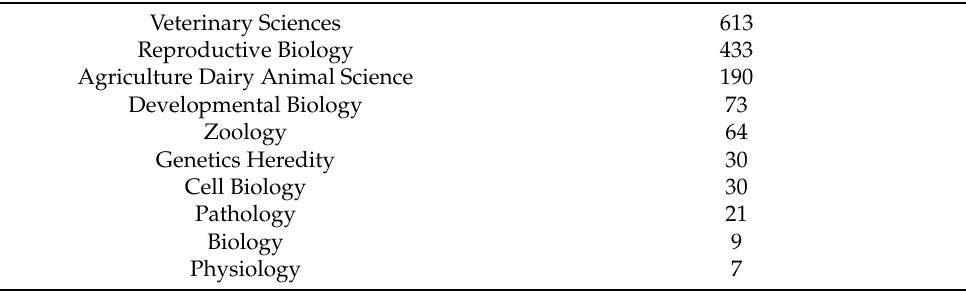
Table 1. Distribution of the retrieved documents by research areas according to Web of